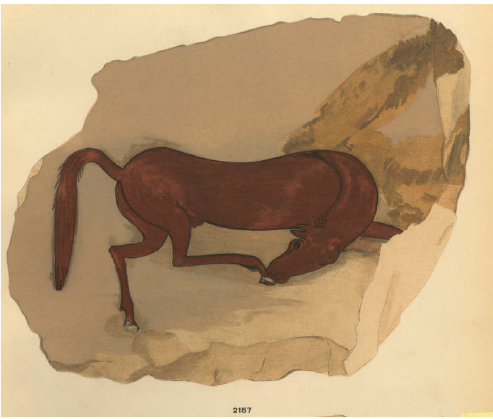
Figure 21. Horse scratching his hind leg on an ostracon from Deir el Medina. Painting by Vandier d’Abbadie, Ca-talogue des ostraca fi gures de Deir el Medineh, 1936. © Ifao, ostracon #2157.